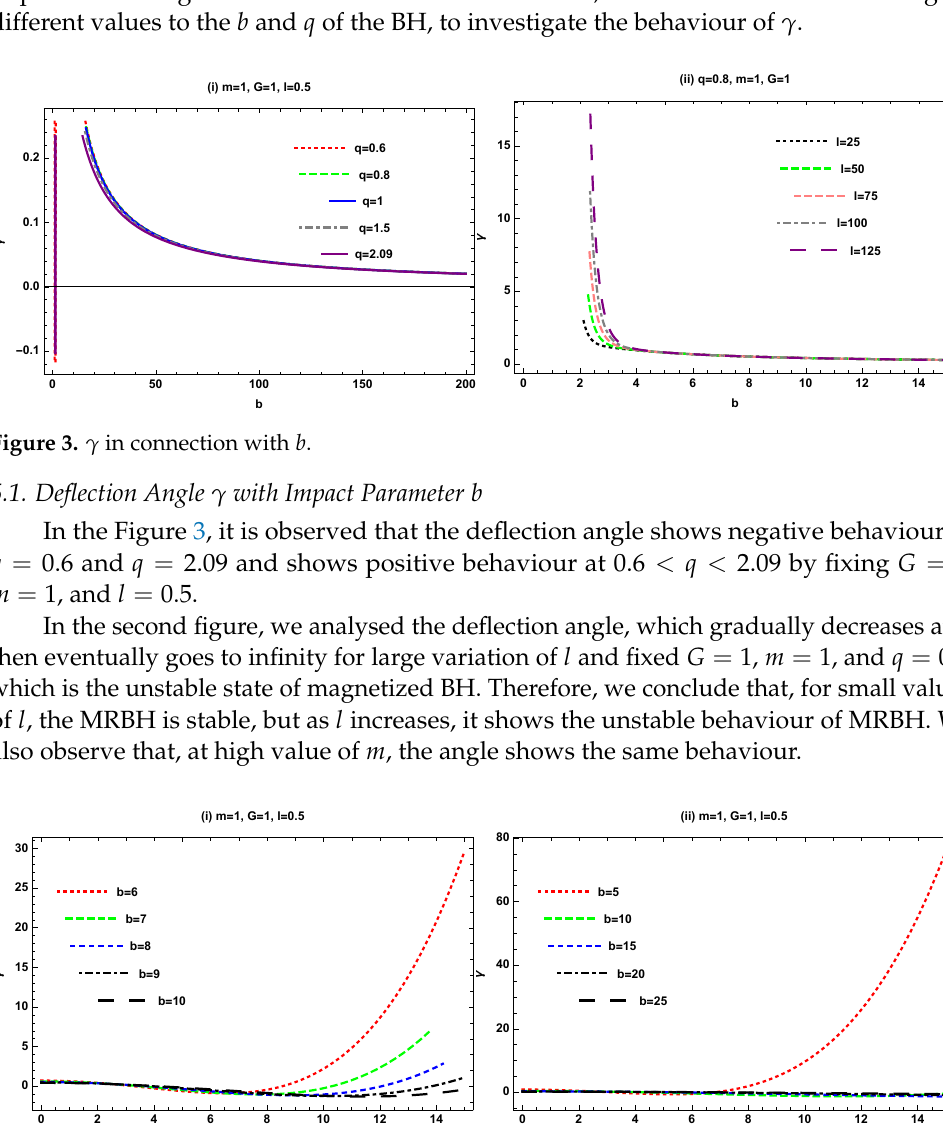
Figure 2: γ in connection with q .